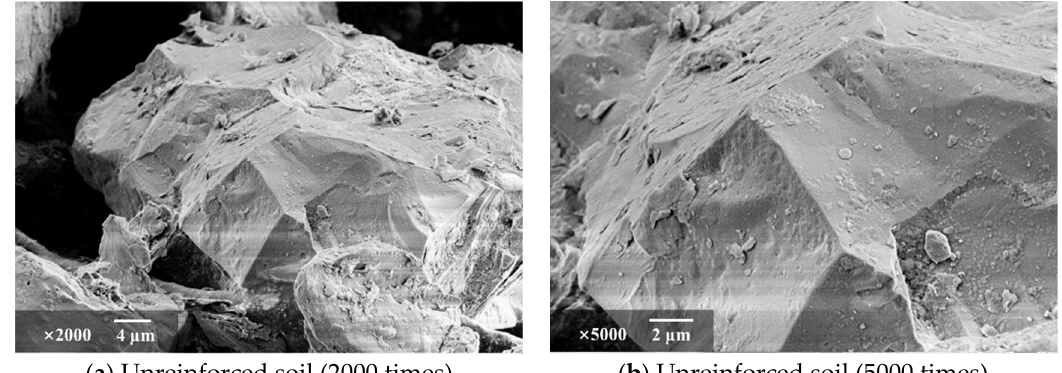
Figure 10. FESEM micrographs of undisturbed soil.